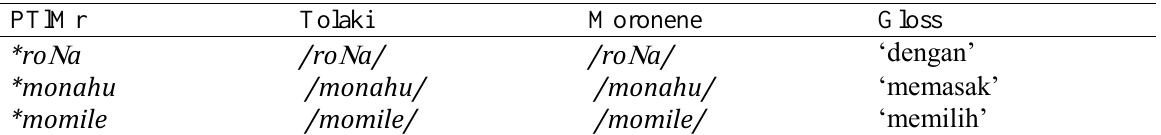
Table 15. The Middle Position Word PTlMr